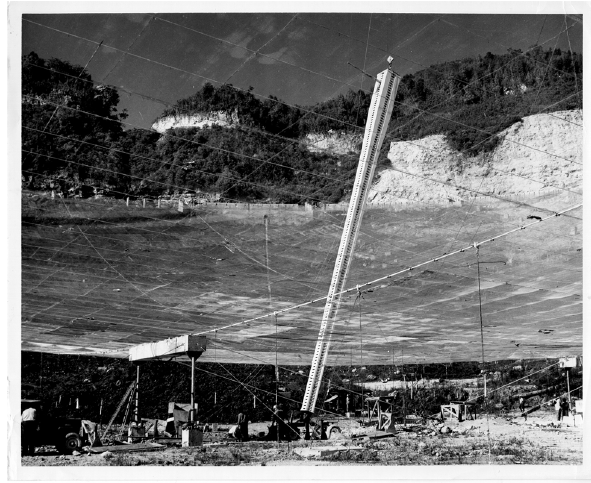
Figure 2. The original 430MHz square cross-section linefeed as it was raised to the carriage house in this photo dated 14 August 1963. Photo courtesy of Cornell University and Arecibo